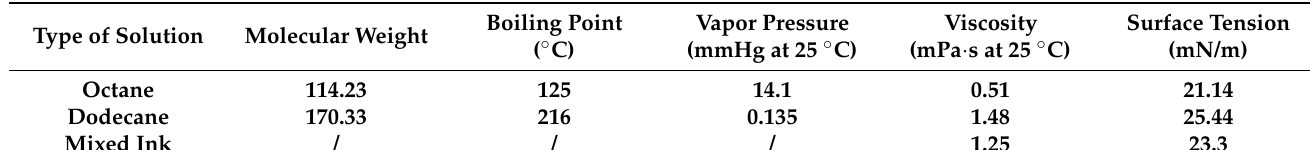
Table 1. Detailed data of solvents and our mixed ink.